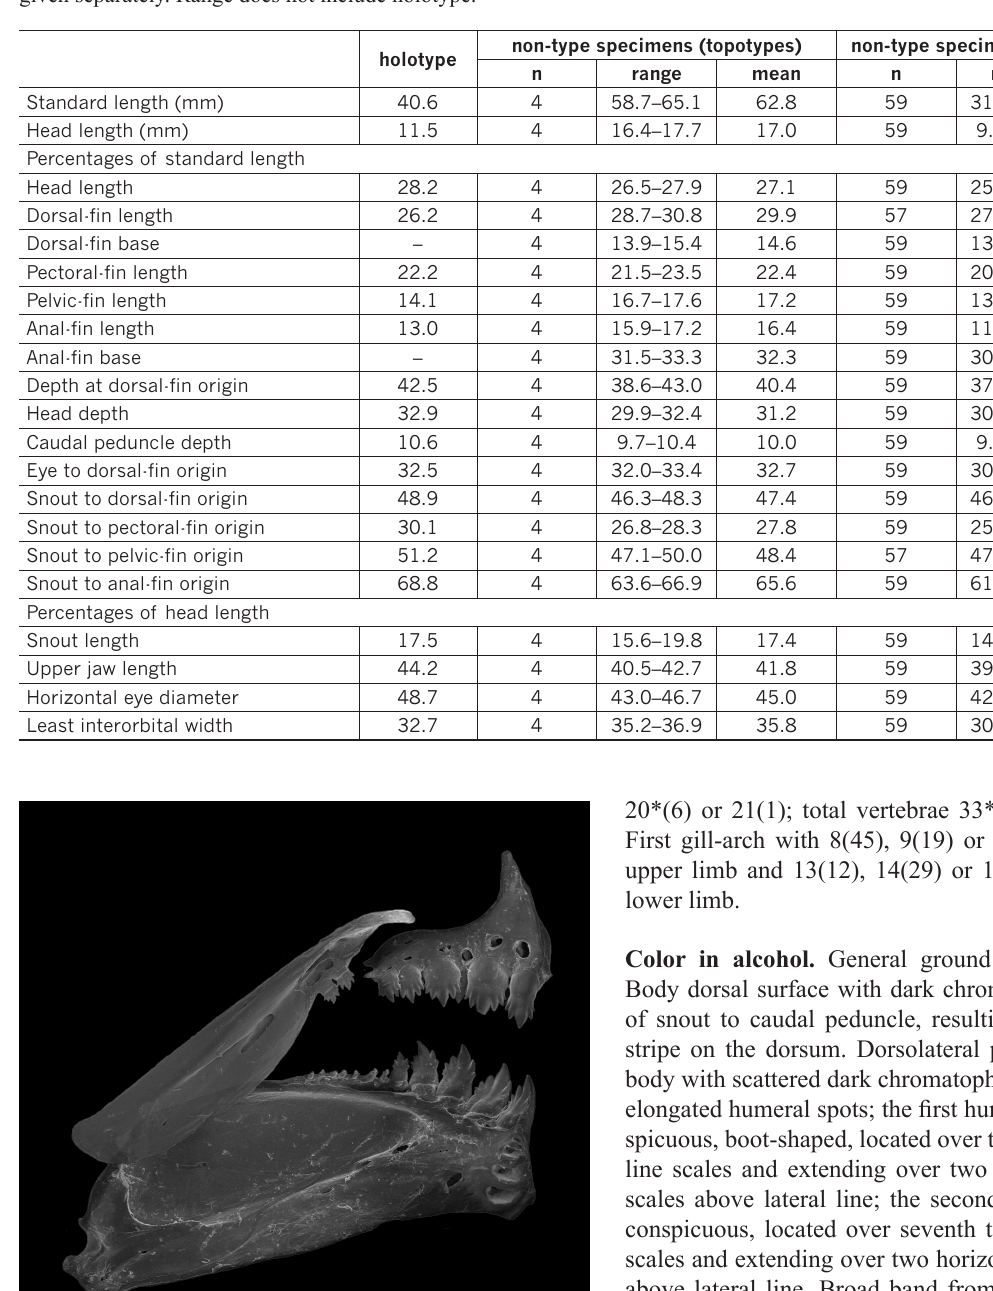
Table 1. Morphometric data of Moenkhausia megalops (n = 64, holotype CAS 71433). Data of topotypes and non-topotypes are given separately. Range does not include holotype.